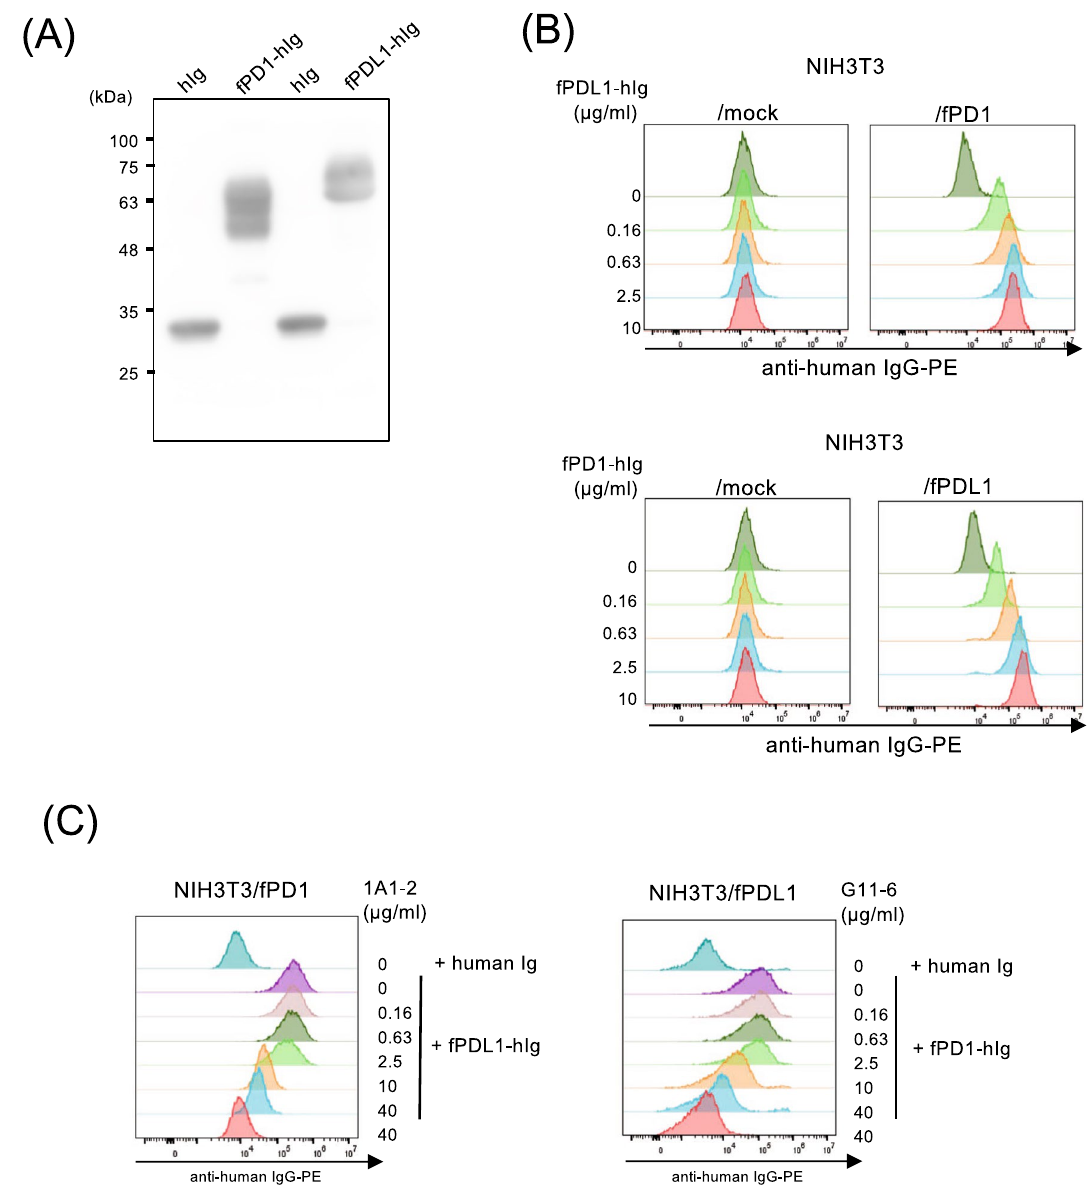
Figure 3. Inhibition of fPD-1 and fPD-L1 interaction by mAbs. ( A ) Western blotting of soluble fPD1-hIg and fPDL1-hIg fusion proteins. fPD1-hIg, fPDL1-hIg, and human IgG 2 -Fc (hIg) were purified from the supernatant of Expi-293F cells and submitted to western blotting with anti-human IgG-horseradish peroxidase (HRP). Full image of western blotting is shown in Supplementary Figure for Fig. 3A. ( B ) NIH3T3 or mock and NIH3T3/ fPD1 and NIH3T3/fPD1 were stained with dose-titrated fPDL1-hIg fusion protein (left panel), or NIH3T3 or mock and NIH3T3/fPDL1 and NIH3T3/fPDL1 with fPD1-hIg (right panel) and followed by staining with a secondary anti-human IgG-PE antibody. ( C ) NIH3T3/fPD1 cells were preincubated with serially titrated anti-PD-1 (1A1-2) mAb, and, after washing, incubated with 1 μg/mL of fPDL1-hIg or human Ig (left panel). NIH3T3/fPDL1 cells were preincubated with anti-PD-L1 (G11-6) mAb, and, after washing, incubated with 5 μg/mL of fPD1-hIg or human Ig (right panel). Cells were then stained with a secondary antibody anti-human